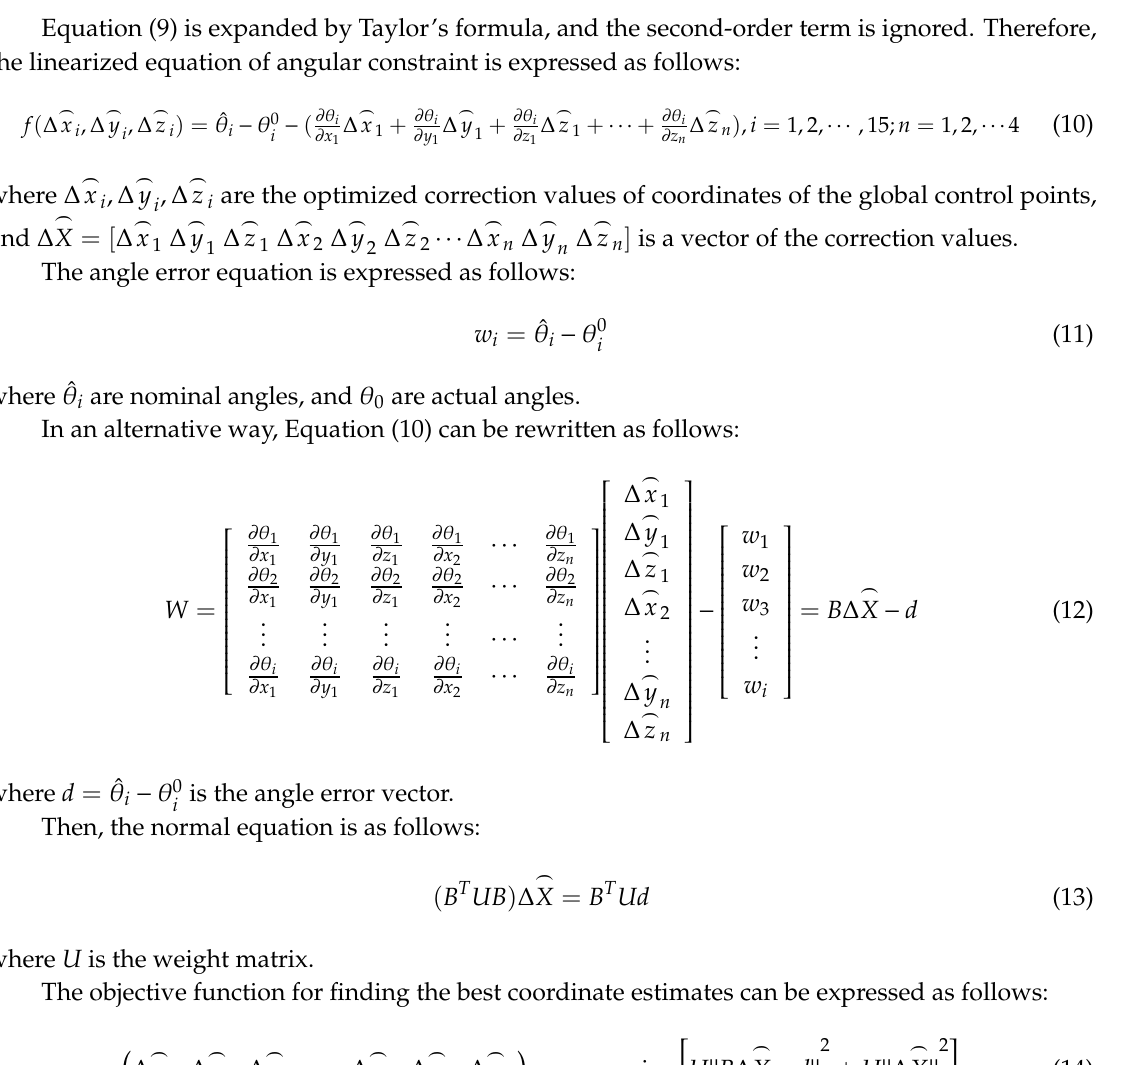
Figure 5. Schematic of the spatial angle.